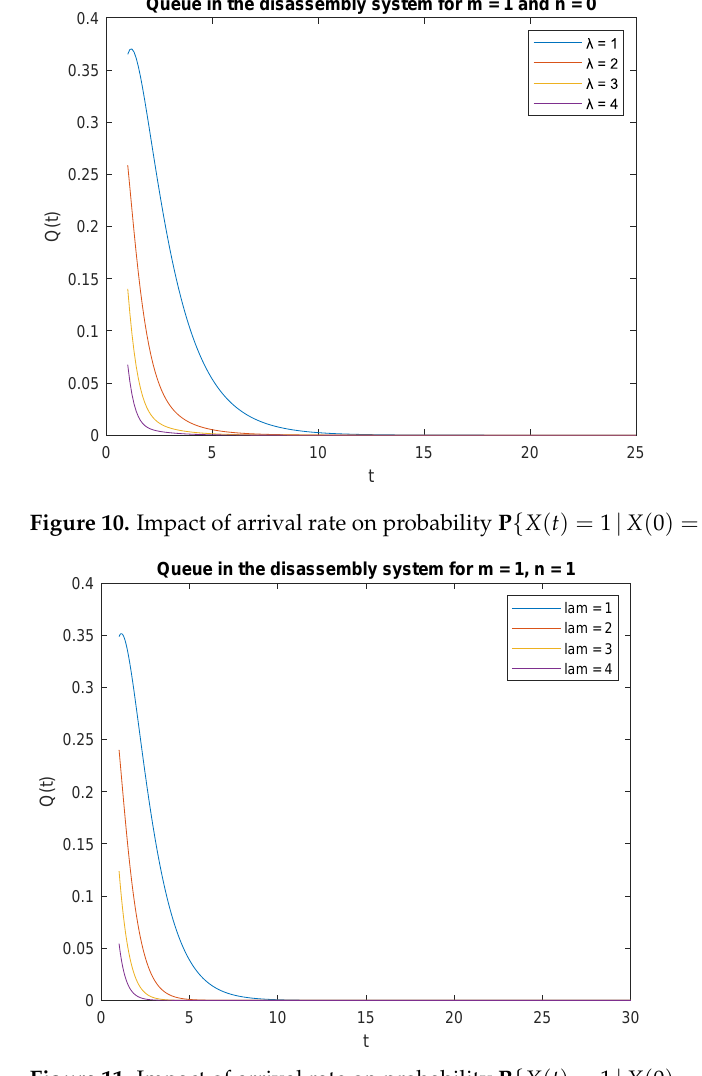
Figure 11. Impact of arrival rate on probability P { X ( t ) = 1 | X ( 0 ) = 1 }